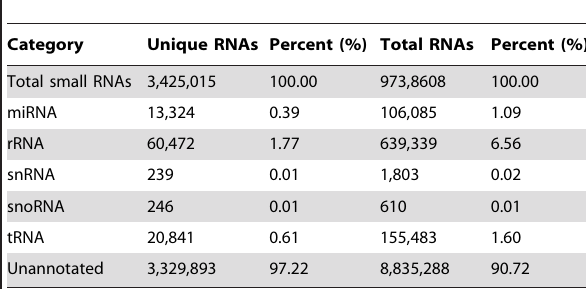
Table 1. Distribution of small RNAs among different categories in P. yezoensis .